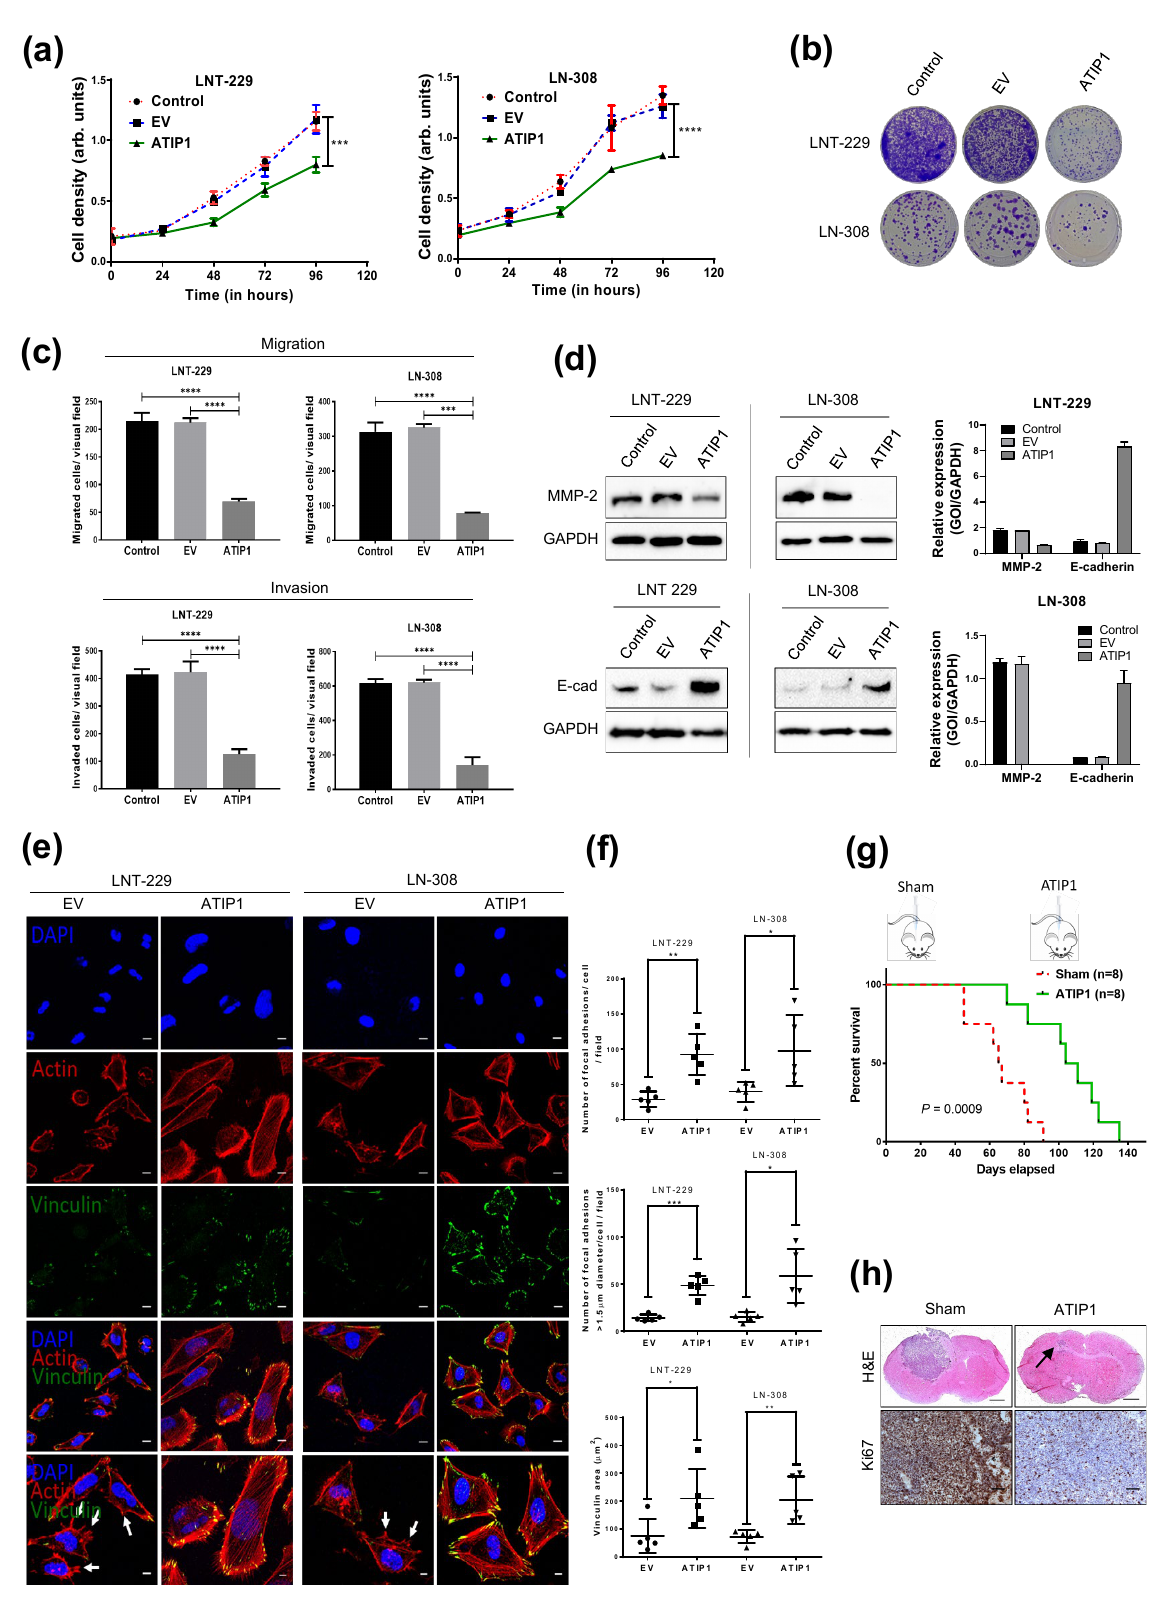
Figure 3. ATIP1 overexpression modulates several pro-tumorigenic characteristics. Parental (control), pcDNA3.1 (EV)